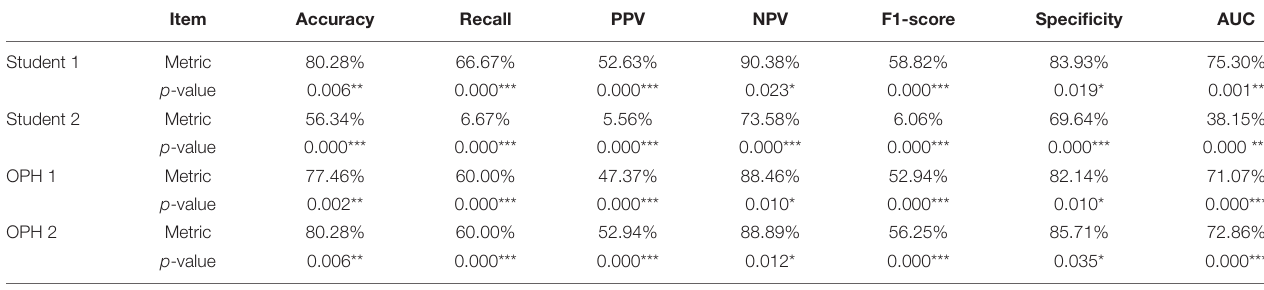
TABLE 7 | The comparison and test results in binary classification.